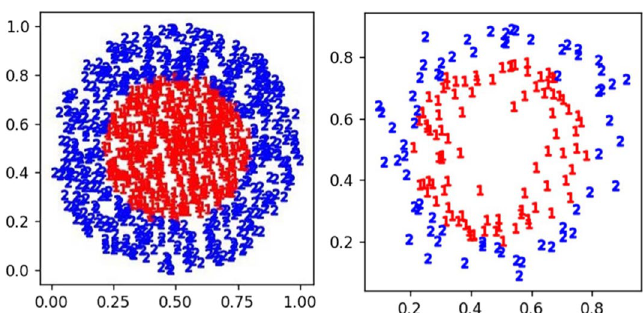
Fig. 2 The distribution of the instances in the artificial data set Circle (left), and the distribution of the instances selected from the artificial data set Circle (right)